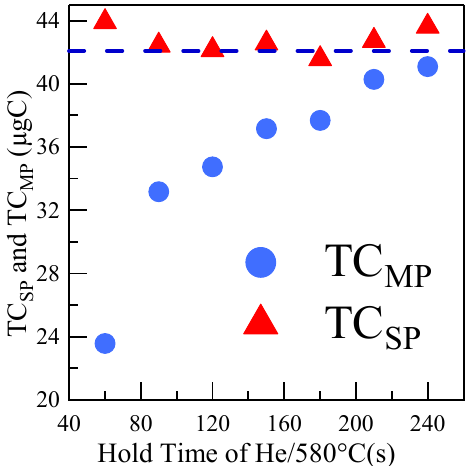
Figure 5. TC recoveries of sucrose with a series protocols based on the IMPlong protocol, with the only differences among these protocols being the hold time of Step OC4. Target Sucrose mass (42.07 μ gC) was shown in dash line for reference.